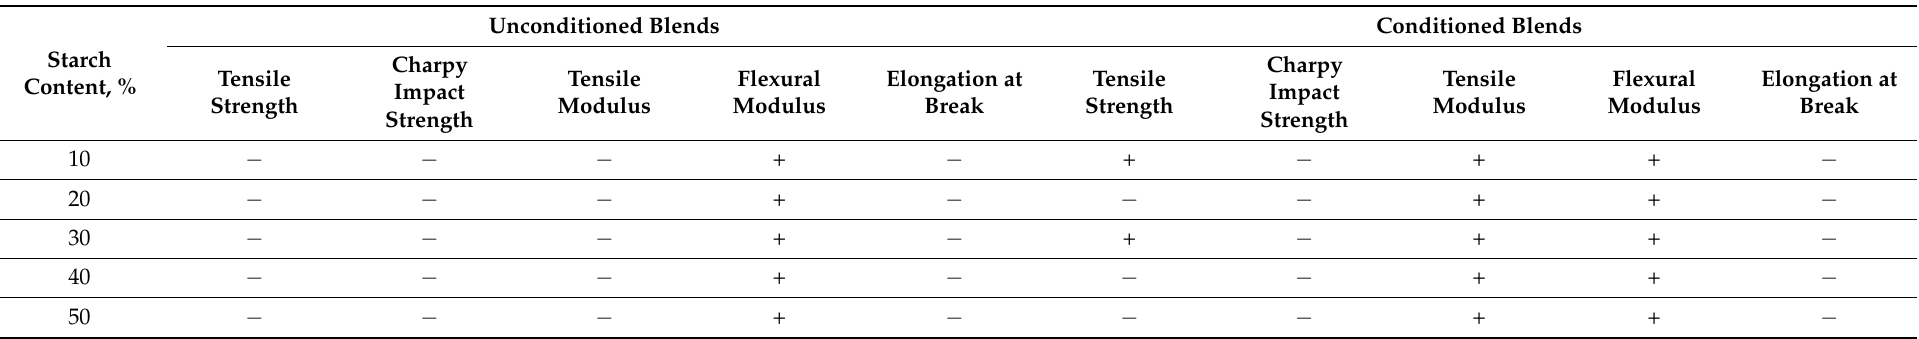
Table 6. Effects on mechanical properties of PLA-g-MA (“+”: positive change relative to an additive-free blend of a suitable composition; “ − ”: negative change relative to an additive-free blend of a suitable